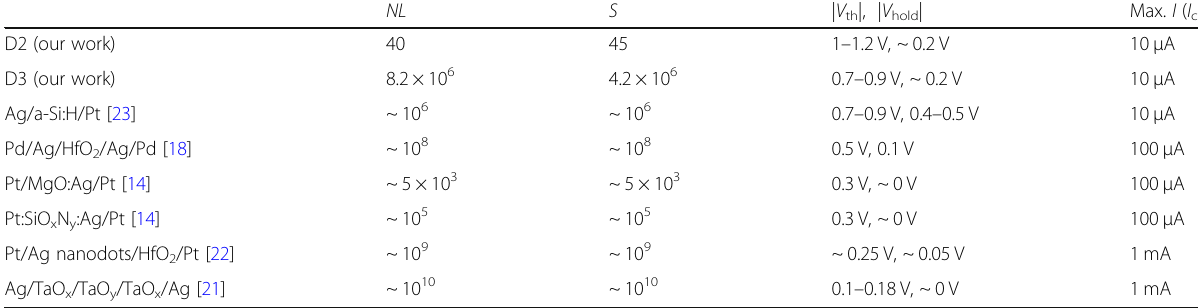
Table 2 Recent reported selectors using Ag-filament TS including our devices